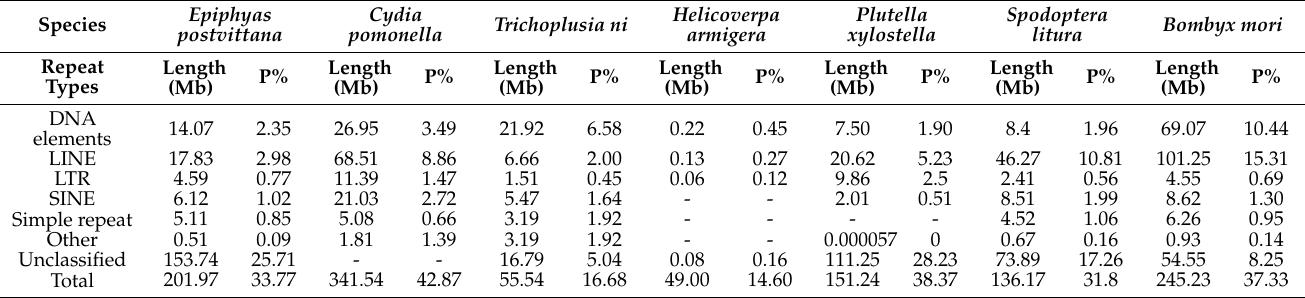
Table 2. Repeat classes in the Epiphyas postvittana genome compared with those of other